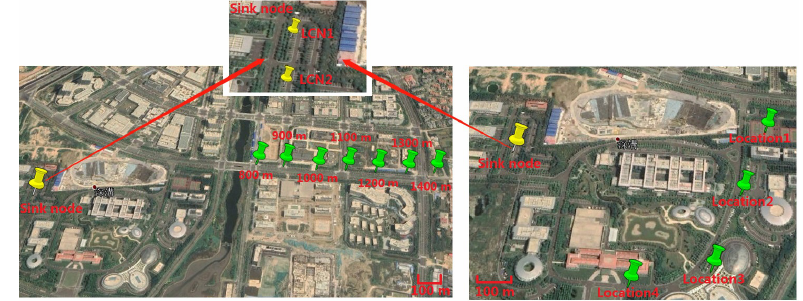
Figure 7. Locations of sensor node and local convergence node in the park